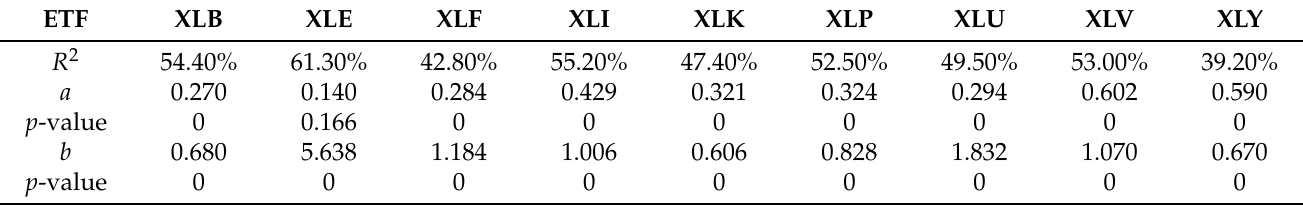
Table 1. Estimated parameters for the slippage loss model (case of γ =